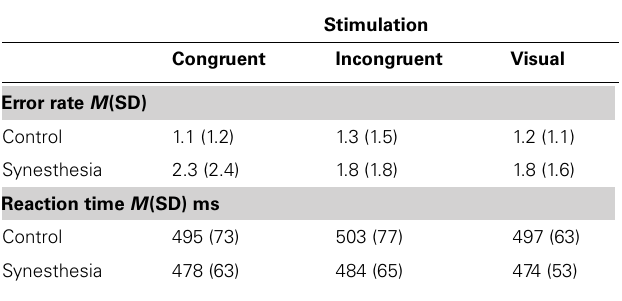
Table 2 | Behavioral